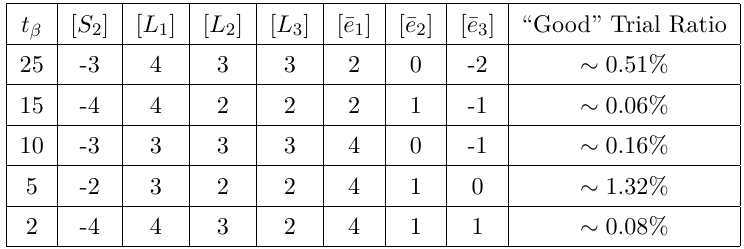
Table 2 . A few sample charge assignments that give rise to SM in the IR quite often. A total of 5 × 10 5 trials are generated for each charge assignment. In the last column we indicate the fraction of these trials that give rise to the observed pattern of masses and mixings among the leptons, i.e., “good” trials as defined in section 3.2. We do find some flexibility in the conditions from eq. (3.8) on the charge assignments; yet, by and large, these conditions give the right ballpark of the charges needed to get a non-negligible number of good trials.